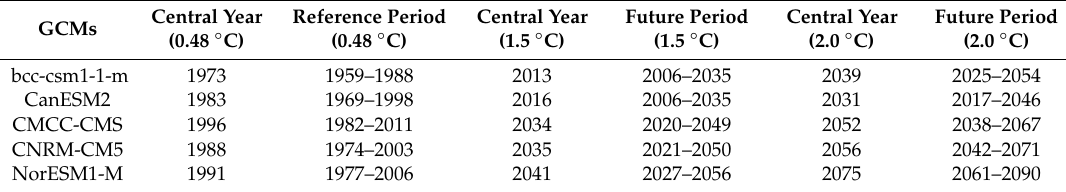
Table 2. Central years and averaged periods for 0.48, 1.5, and 2.0 ◦ C global warming under the RCP4.5 scenario for the individual